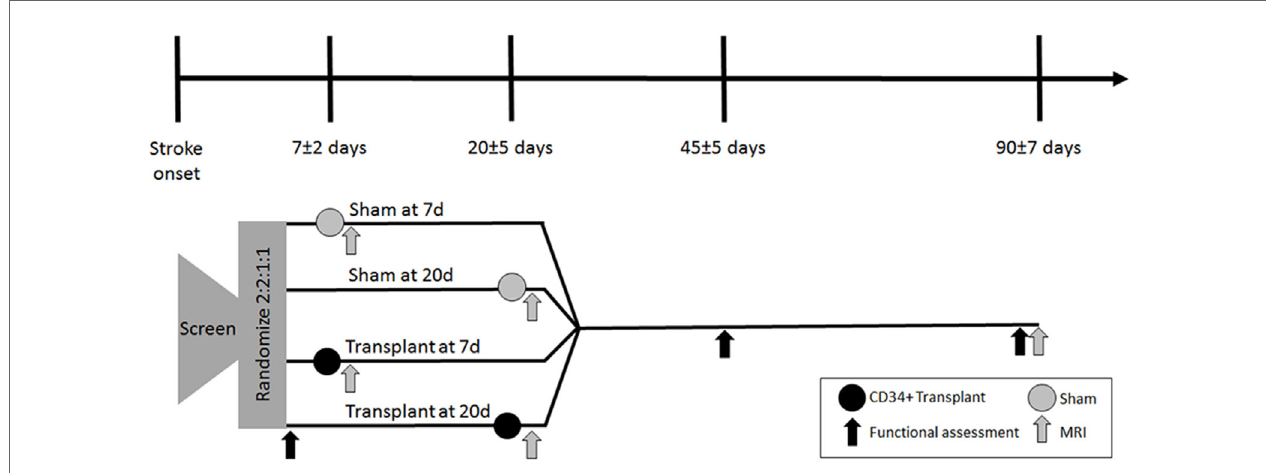
FigurE 1 | Trial design flow chart. Abbreviations: MRI, magnetic resonance imaging; d,